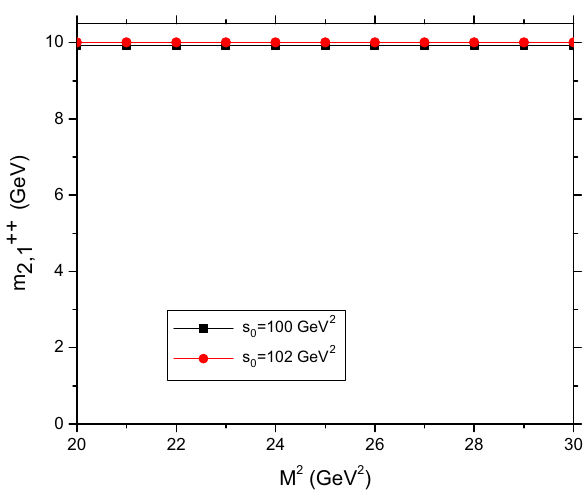
Fig. 8 Borel parameter dependence of J PC = 1 ++ meson mass from (cid:10) ( 2 ) μναβ for different s 0 values